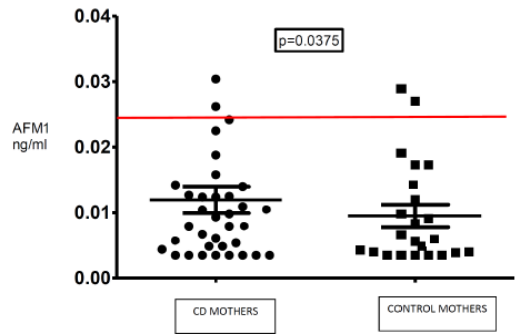
Figure 1. Aflatoxin M1 (AFM1) mean breast milk concentration for each of the CD and control mothers. Means were obtained by averaging individual samples for each subject. The red line represents the maximum AFM1 threshold established by the European Union for infant formulas.